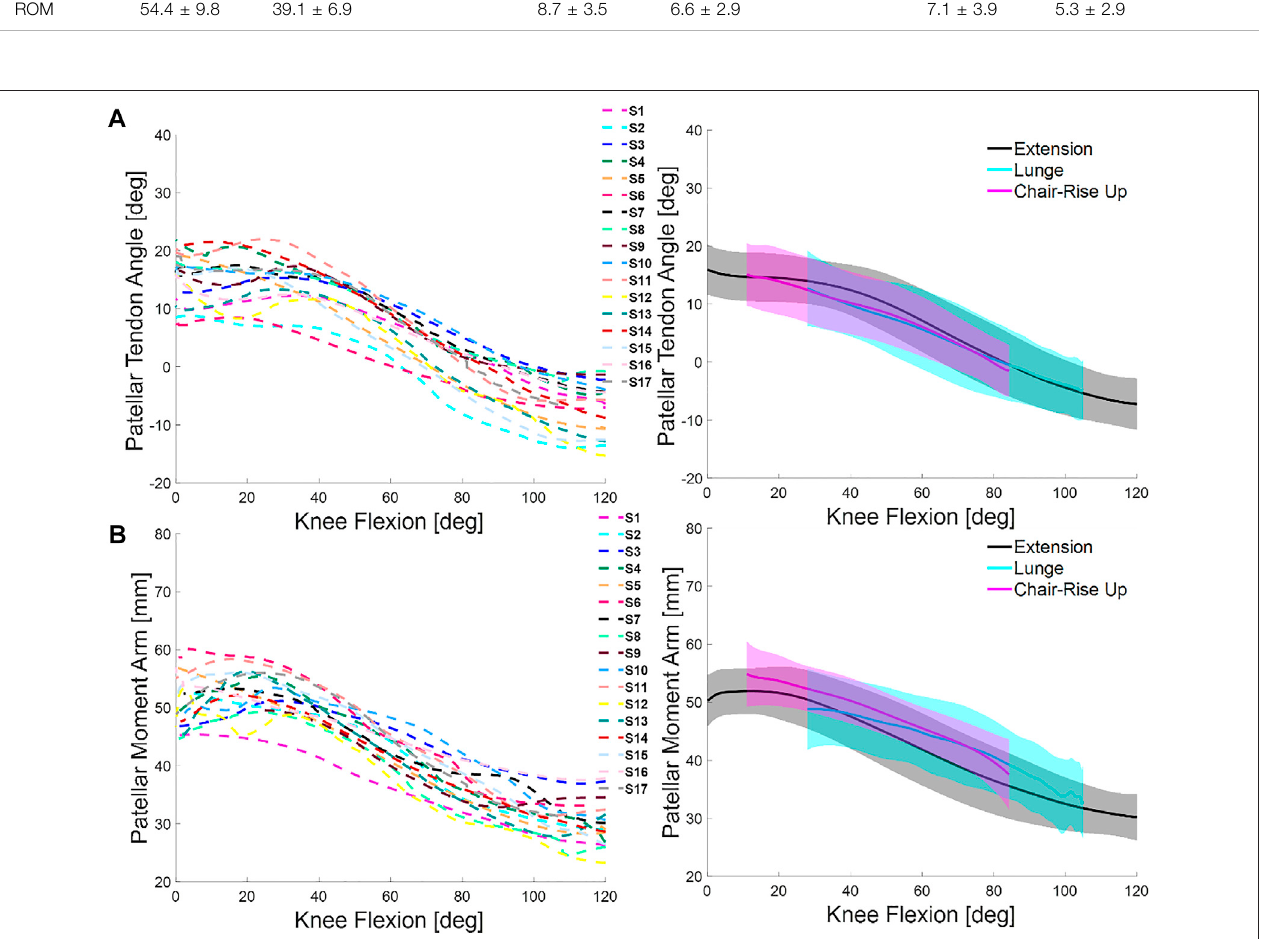
FIGURE 4 | (A) Comparison of patellar tendon angle (PTA) across subjects during the seated knee extension (left) and comparison of average and one standard deviation across activities (right). (B) Comparison of patellar tendon moment arm (PTMA) across subjects during the seated knee extension (left) and comparison of average and one standard deviation across activities